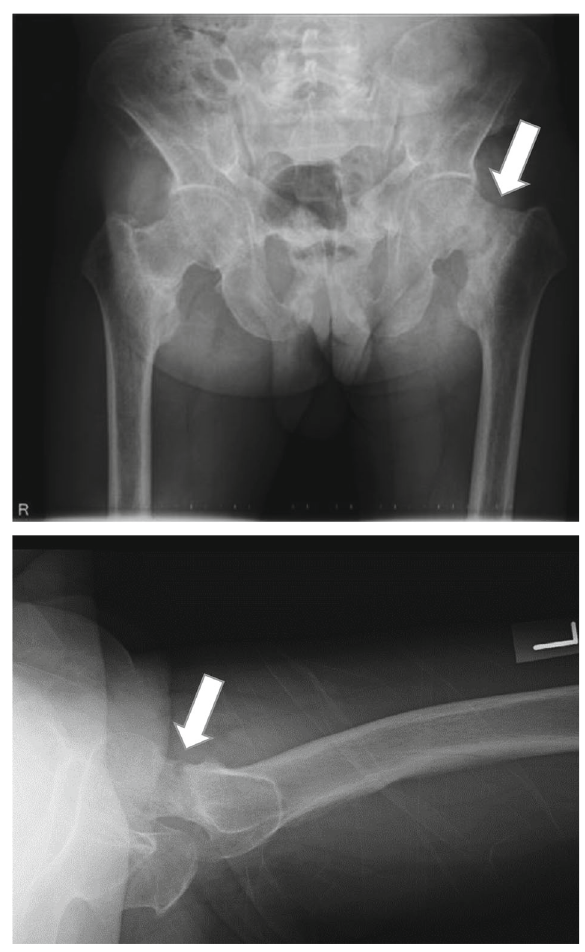
Figure 3: Radiographs in 2016 revealing left femoral neck fracture and varus deformity at the fracture